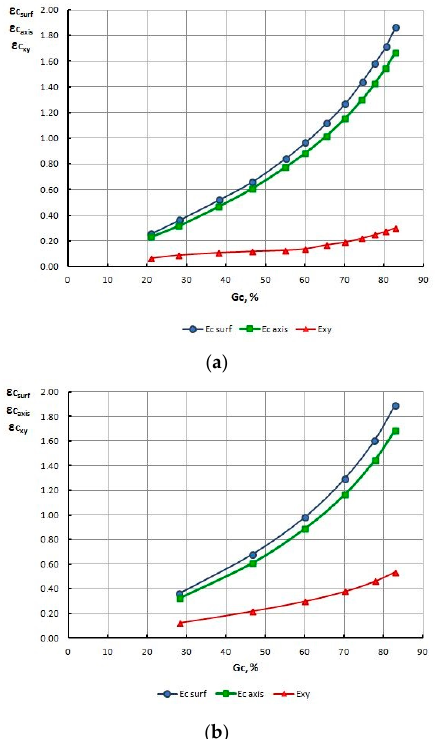
Figure 11. Change of strain level on the surface ε c surf , axis ε c axis and non-dilatational strain ε xy in wires drawn with low ( a ) and high ( b ) single section reductions, at a drawing speed of V c = 1.6 m/s, as a total drawing reduction function.